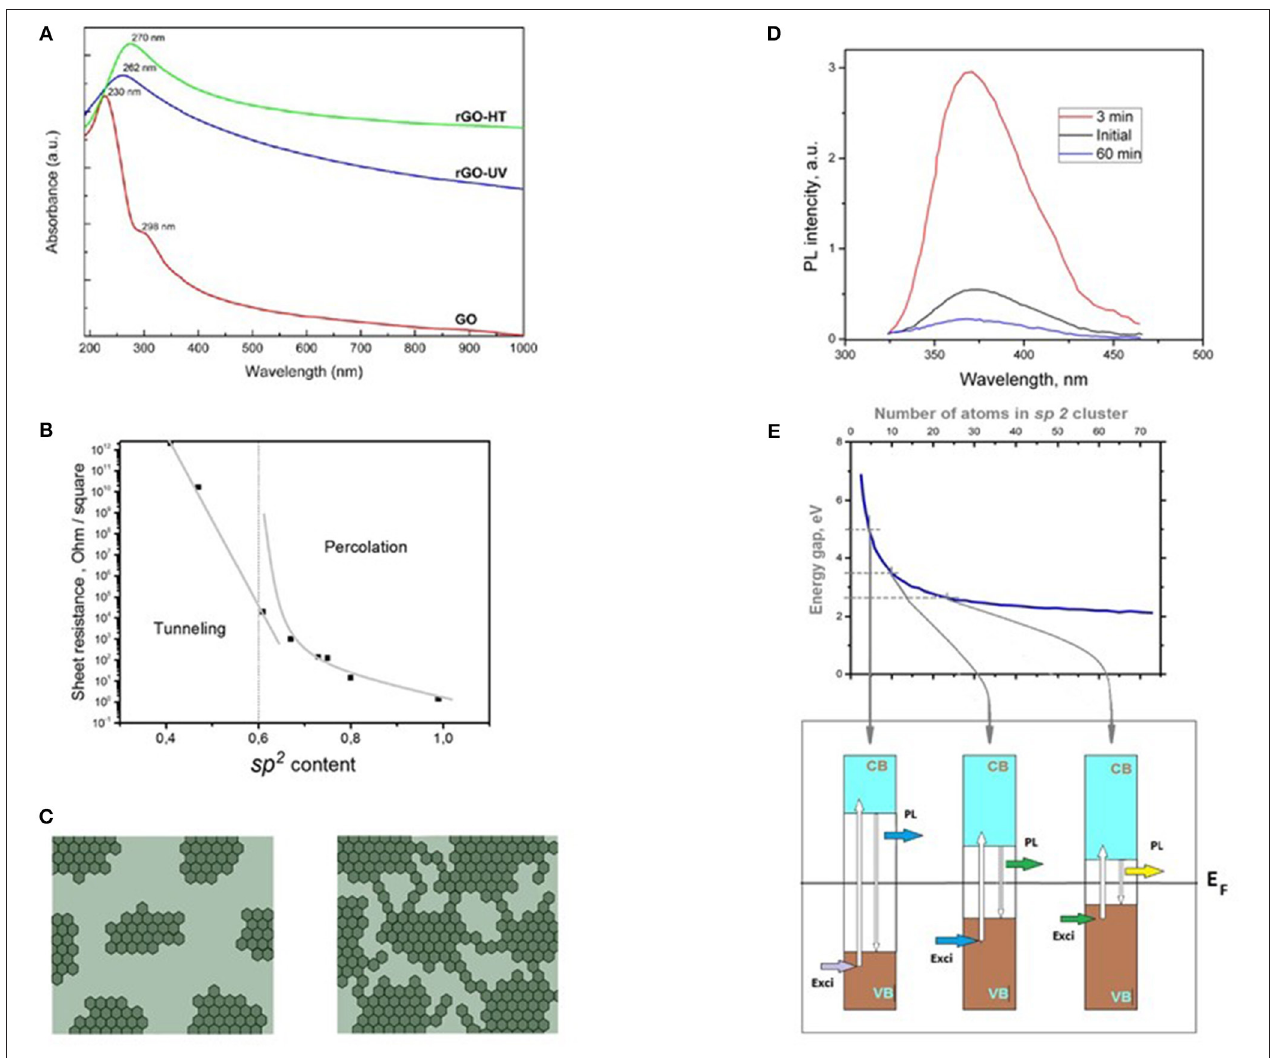
FIGURE 2 | Physical properties of GO. (A) Transformation of light absorption spectra of GO under thermal (rGO-HT) and UV reduction (rGO-UV). Adopted with permission from Kumar et al. [ 32] 2013 Nature. (B) Sheet resistance of thermally reduced GO vs. sp 2 carbon content. The vertical dashed line indicates the percolation threshold at sp 2 fraction of ∼ 0.6. By data from Mattevi et al. [ 22]. (C) Schematic of evolution of GO domain structure at reduction: left—initial GO, right—partially reduced. In dark gray indicated sp 2 graphene regions, in light gray— sp 3 oxygen containing area. Accordingly to Mattevi et al. [ 22]. (D) PL luminescence spectra of progressively reduced GO films. The total time of exposure to hydrazine is noted in the legend. Excitation wavelength is 325nm. Data from from Eda et al. [33]. (E) Explanation of florescence of GO. At top: Estimated energy gap of π - π * transitions as a function of the number atoms in graphene domain. At bottom: Schematic band structure of GO [blue and brown represent conduction (CB) and valence bands (VB), respectively]. Smaller sp 2 domains have a larger energy gap due to a stronger confinement effect. Photogeneration of an electron–hole (e–h) pair on absorption of light (Exci) followed by relaxation and radiative recombination resulting in fluorescence (PL) is depicted. White arrows denote the transitions of electrons and holes during this process. Accordingly to Eda et al.